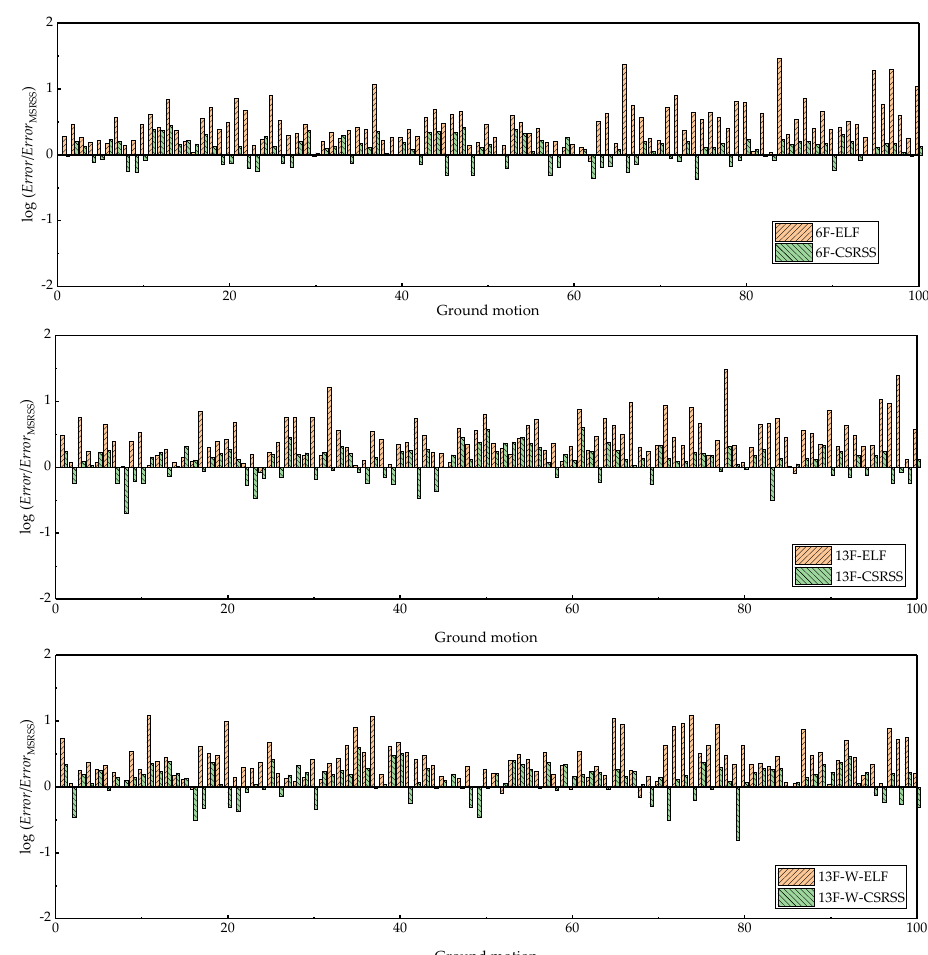
Buildings 2023 , 13 , x FOR PEER